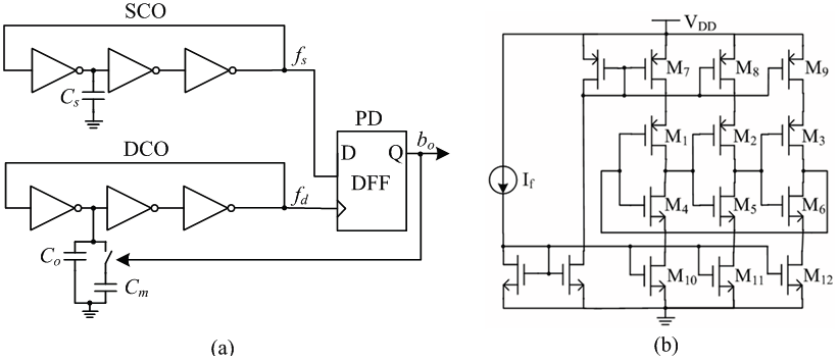
Figure 5. Proposed capacitive sensor interface: ( a ) architecture and ( b ) schematic of current-starved